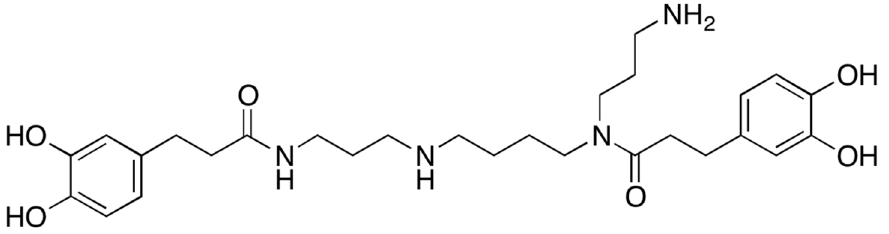
Figure 1. The chemical structure of the isolated kukoamine B.